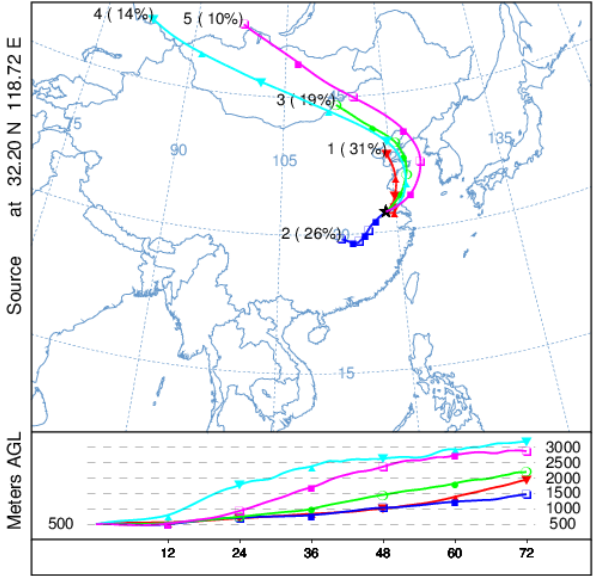
Figure 3. Cluster analysis for backward trajectories of air masses during the whole sampling periods. The different colors indicated different clusters of the backward